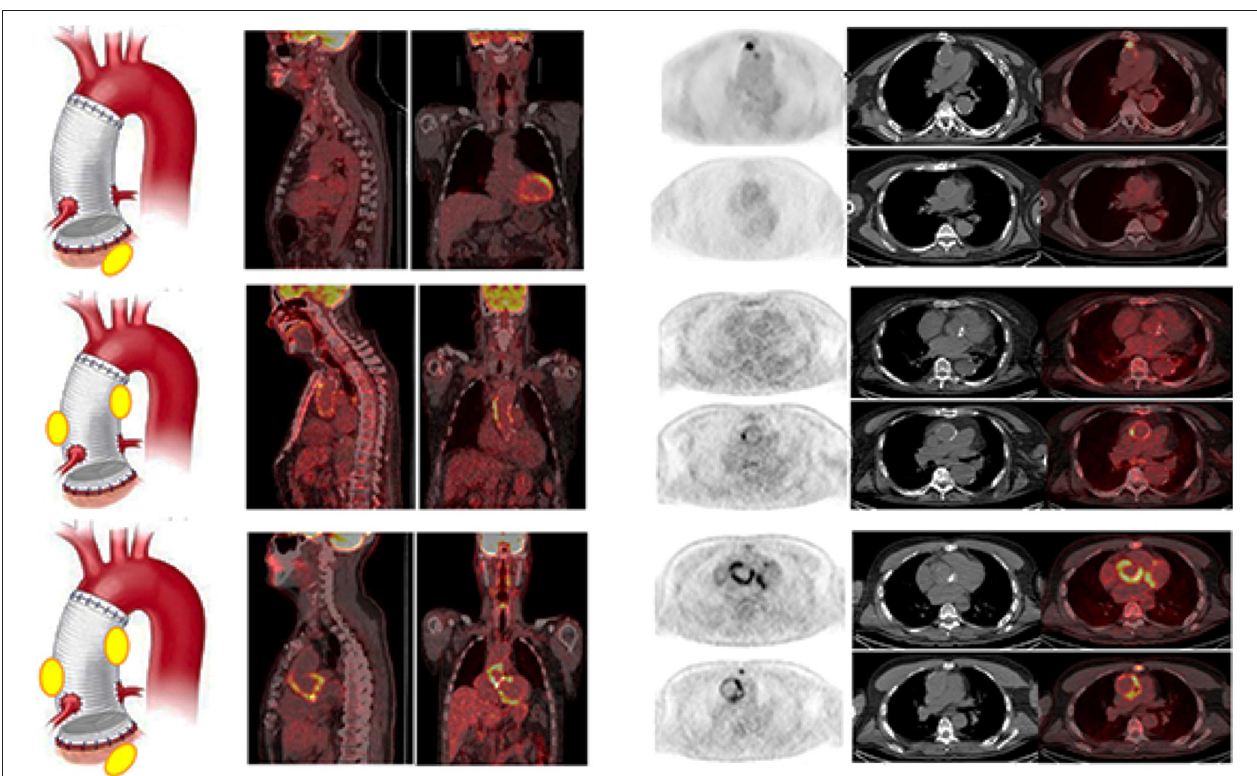
FIGURE 3 | Examples of [ 18 F]FDG PET/CT in patients with final diagnosis infection involving the AV (upper panel), the TG (middle panel), and at both the AV and TG (AVTG, lower panel) as shown by the PET/CT images of the thorax (from left to right, superimposed sagittal and coronal and transaxial emission, CT and superimposed images at both the TG and the AI levels) showing area of focal radiopharmaceutical uptake involving limited to the aortic prosthetic valve, to the tube graft, or involving both the component of the composite prosthesis. The left panel of the figure shows a schematic representation of the final diagnostic category.